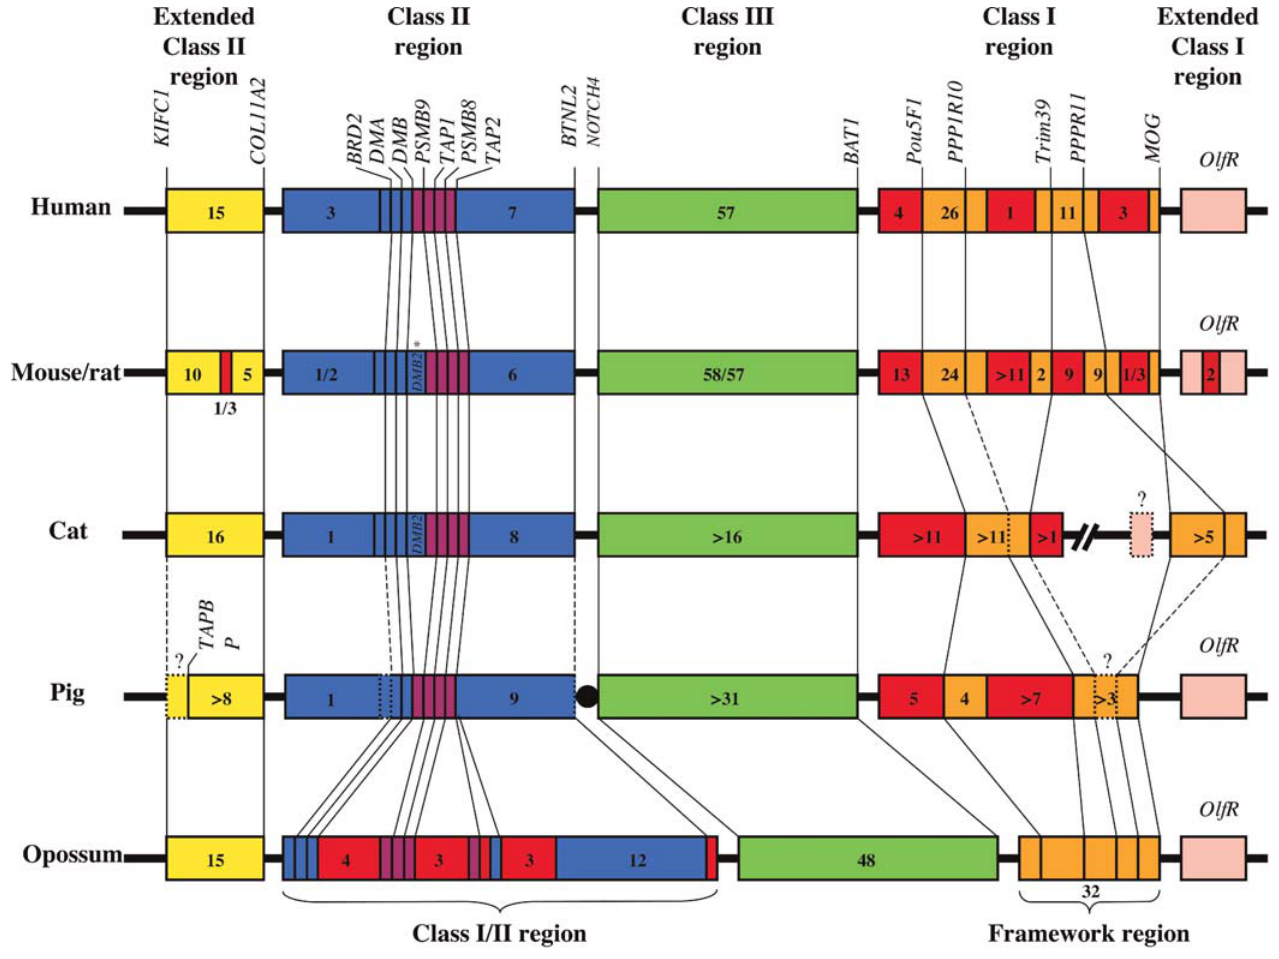
Figure 3. Comparative Map of the MHC Organization in Mammals The color code is the same as in Figure 1. Orthologous genes are indicated by connecting lines. Dashed lines and question marks represent unknown or uncertain data for a given gene or portion of the genome. The total number of genes is reported for each region or sub-region (pseudogenes are not included). Map is not drawn to scale. Unless specified, the small boxes represent single genes. This map was generated using data from [2,47]. The asterisk in the figure indicates that the duplication of DMB concerns only the mouse. DOI: